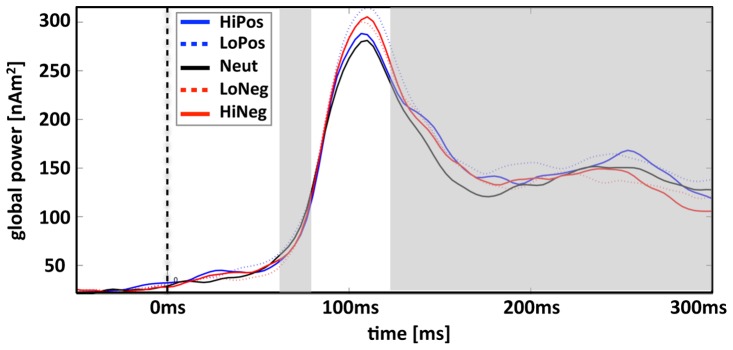
Plot displaying the global power of the estimated neural activity across time over all participants and all test sources.The two a-priori defined time-intervals of interest used for statistical analysis (60–80 ms, 120–300 ms) are marked in gray.